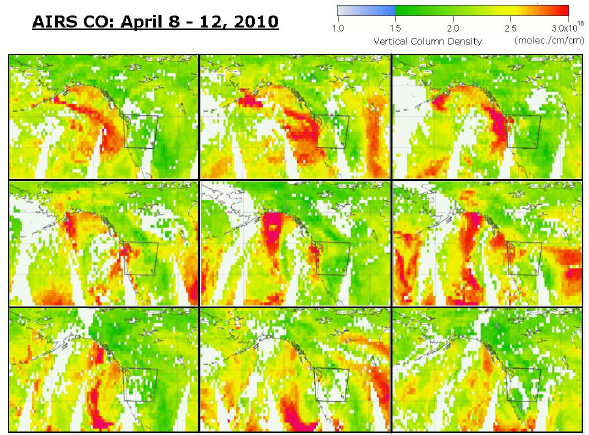
Fig. 15. AIRS carbon monoxide columns for 8–12 April over the Pacific Northwest from the AIRS level-3 data product. Borders of the AIRPACT-3 domain inserted for reference. Frames are 12h apart and sequence from left to right, top to